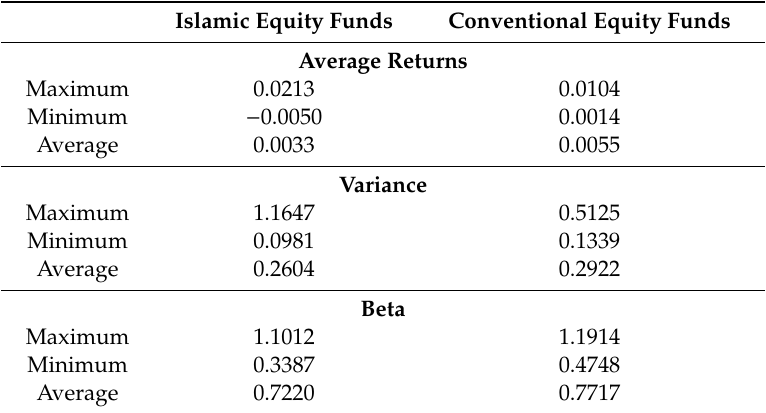
Table 1. Descriptive Statistics of Monthly Returns.